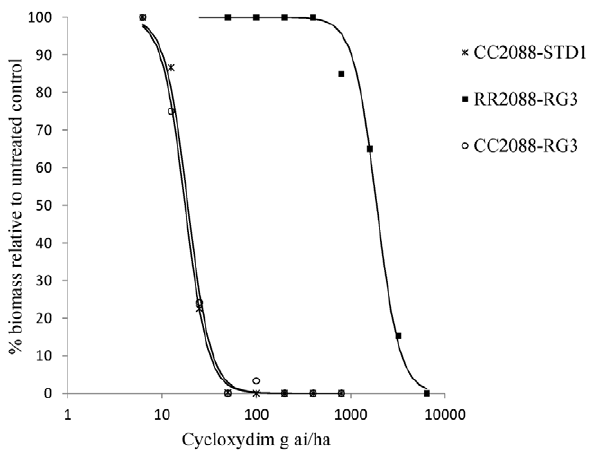
Lanes 1 and 10: DNA ladder, lanes 2, 3 and 4: homozygous mutant RR2088, lanes 4, 5, 6: heterozygous CR2088 plants, lanes 7, 8, 9: homozygous wild CC2088 plants.